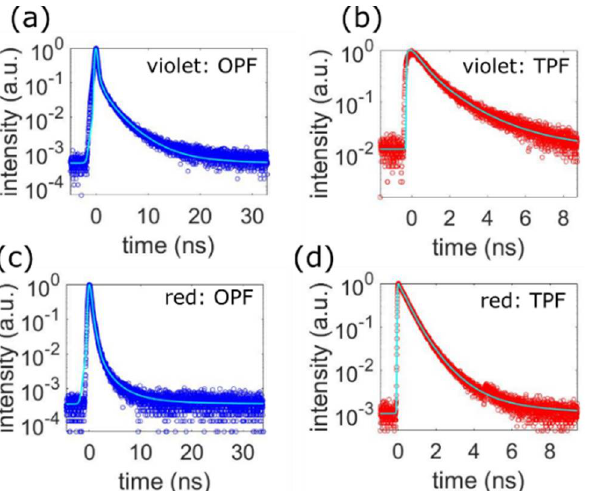
Figure 6. Fluorescence dynamics and model fits (Equation (1)) for OPF (blue points) and TPF (red points). ( a ) MEH-PPP one-photon dynamics ( b ) MEH-PPP two-photon dynamics ( c , d ) the same as above but for MEH-PPV.